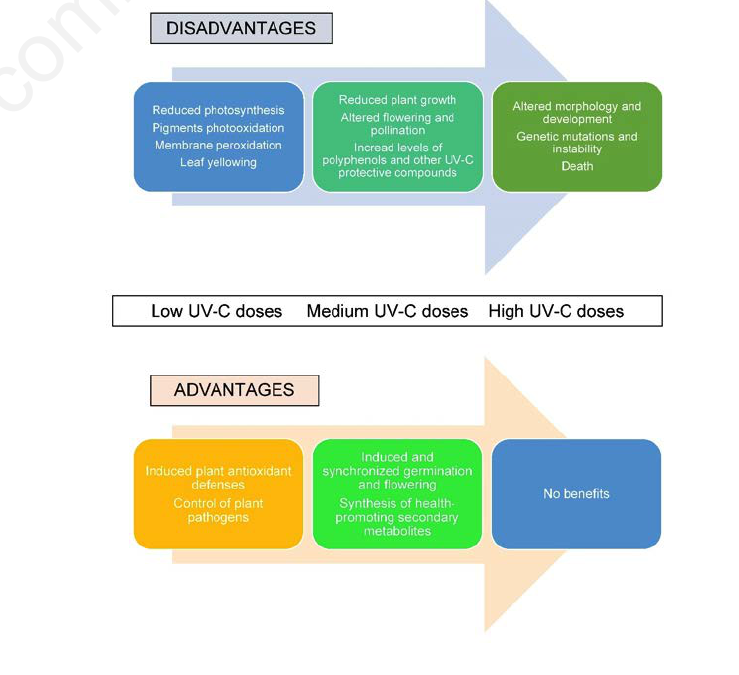
Figure 1. Disadvantages and advantages related to the irradiation of photosynthetic organisms to increasing doses of UV-C